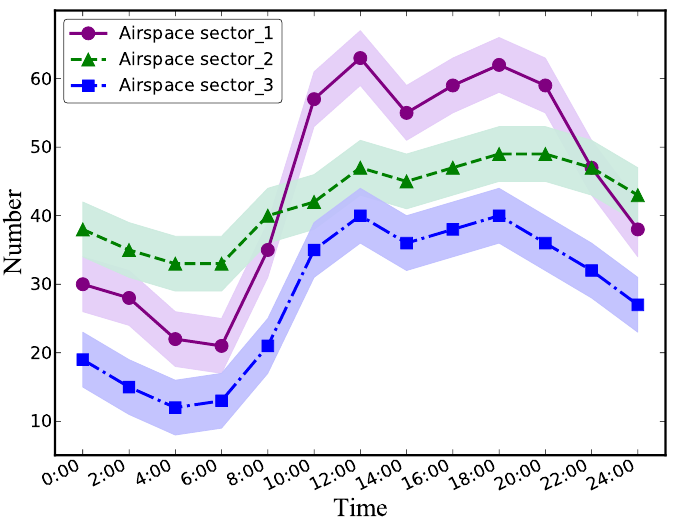
Figure 10. The air traffic flow results of different sectors within the Nanjing–Beijing